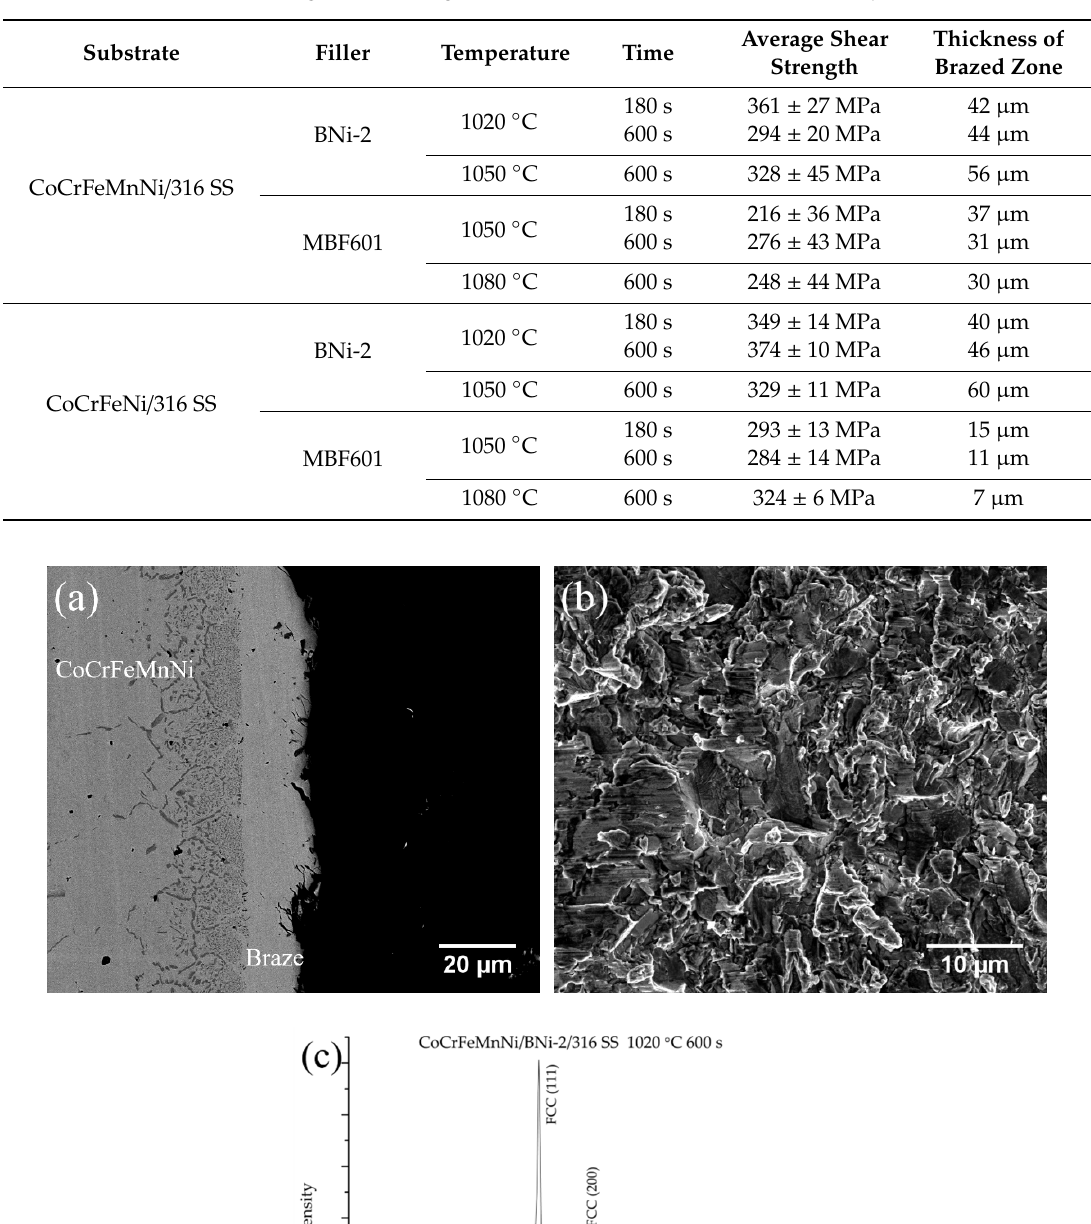
Table 6. Average shear strengths and thicknesses of the infrared brazed joints.